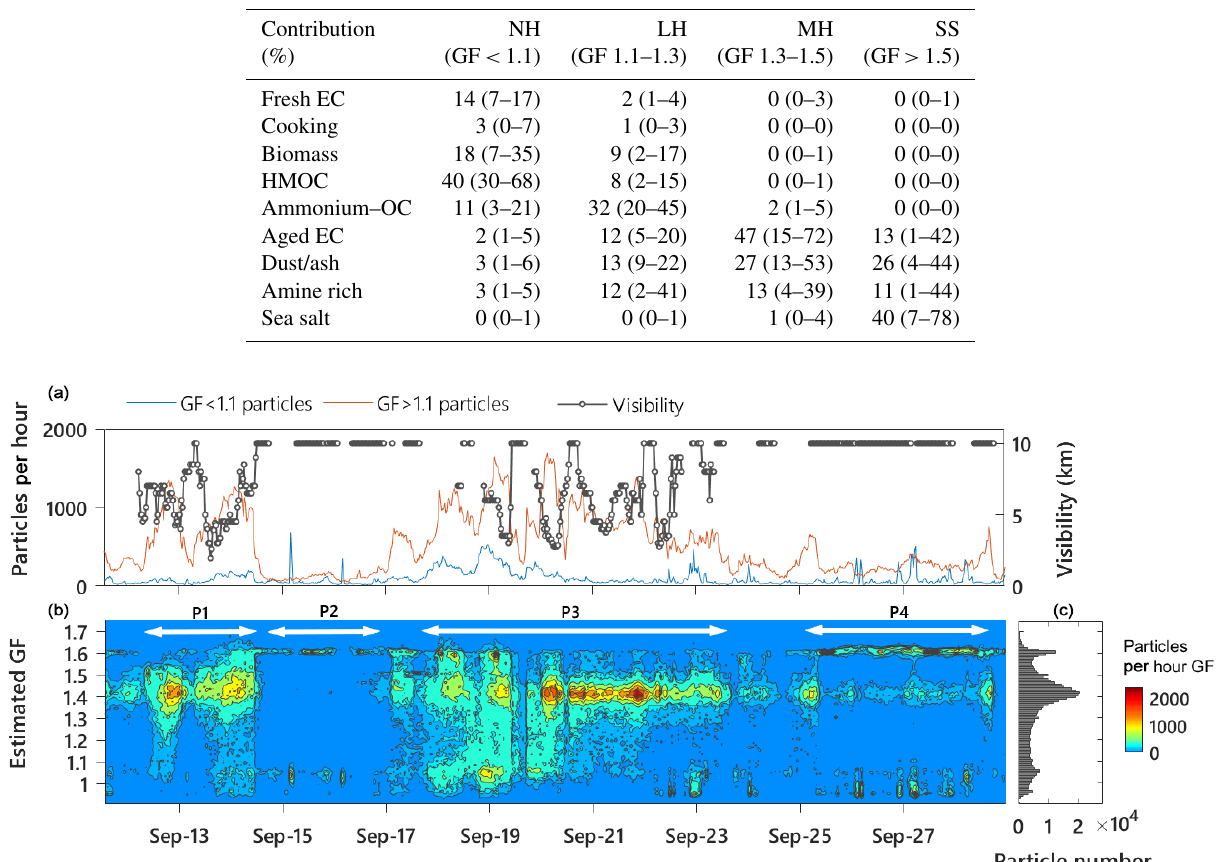
Table 2. Statistics on particle number contributions of ATOFMS particle types to different GF modes. The statistics are the average contri- butions and variation ranges (in brackets) based on temporal data at daily resolution.